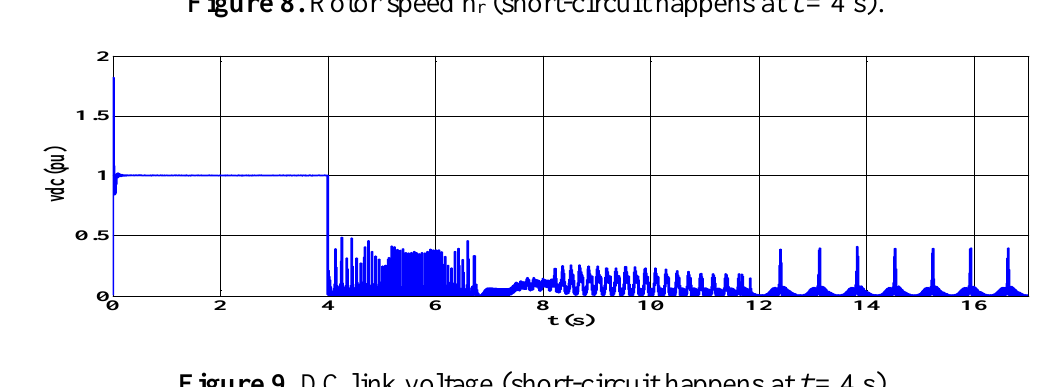
Figure 9. DC link voltage (short-circuit happens at t = 4 s).